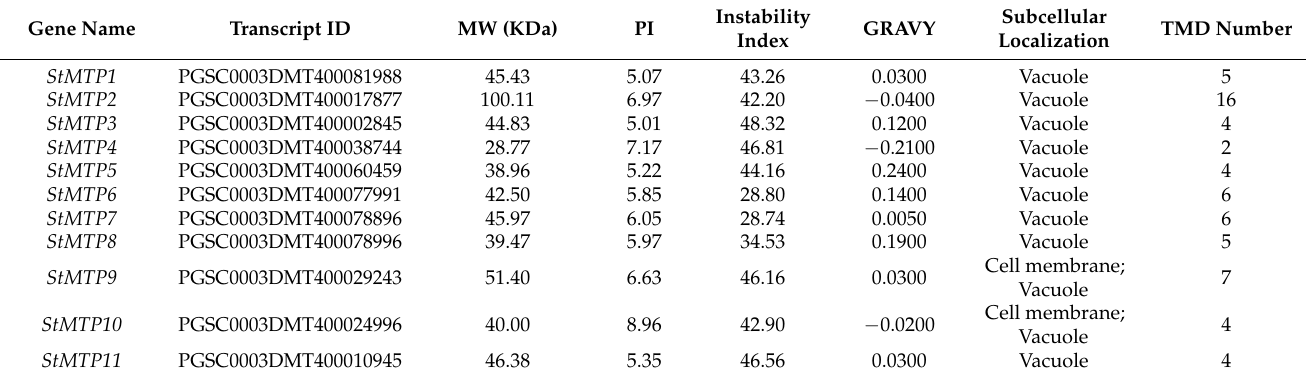
Figure 4. StMTPs structure analysis and conservative motif analysis. StMTPs 1–11 is marked as red 1–11, blue numbers 1–12 represent AtMTP1-AtMTP12. ( A ): The exon-intron structure of StMTP s, the black line represents the introns, the yellow box denotes the untranslated 5 (cid:48) and 3 (cid:48) regions of the UTR and the green box indicated as the exons. The length of the exons, introns and untranslated regions were estimate by the scale bar. ( B ): Schematic diagram of conserved motifs. The different themes were represented by different colored boxes and the length of each sequence were marked. The scale bar on the left indicates the length of the MTP protein sequence. Table 1. The basic physical and chemical properties of StMTP family in